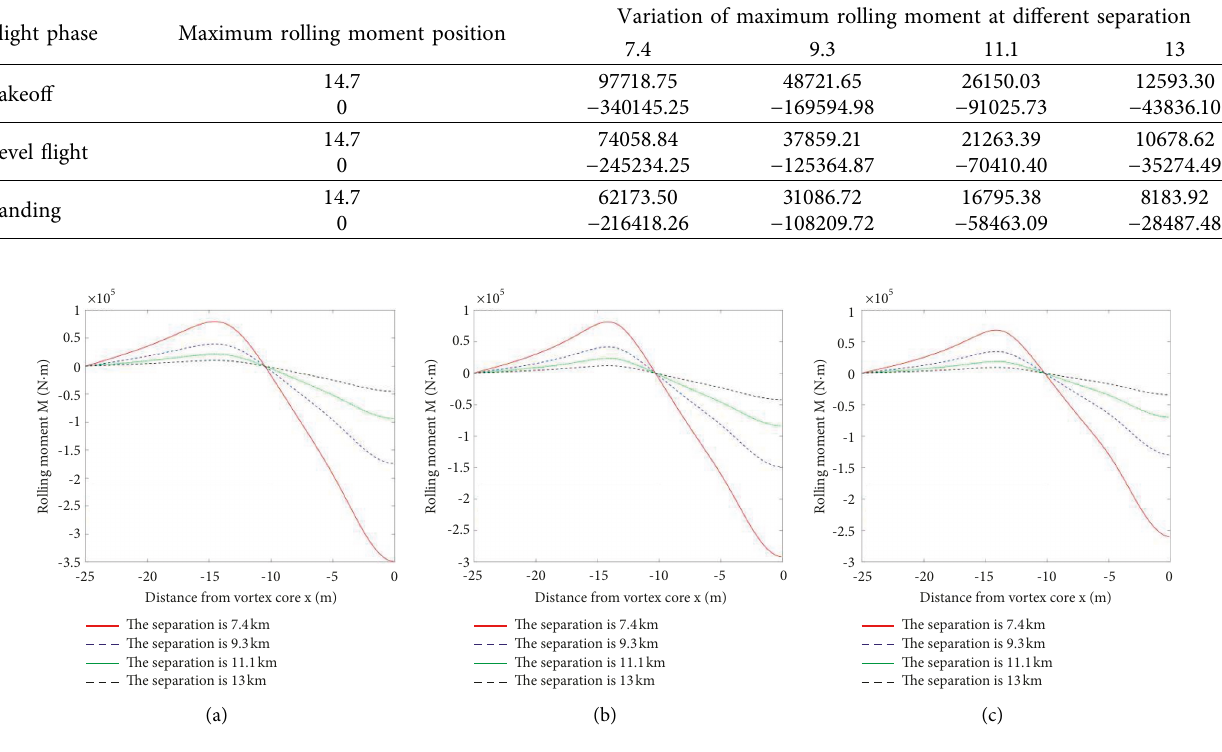
Table 7: Variation of maximum rolling moment of single vortex encountered in longitudinal direction.